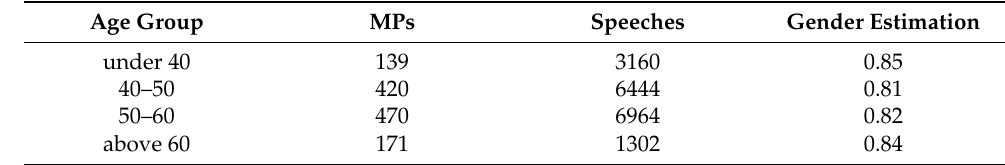
Table 6. Impact of the age on the gender